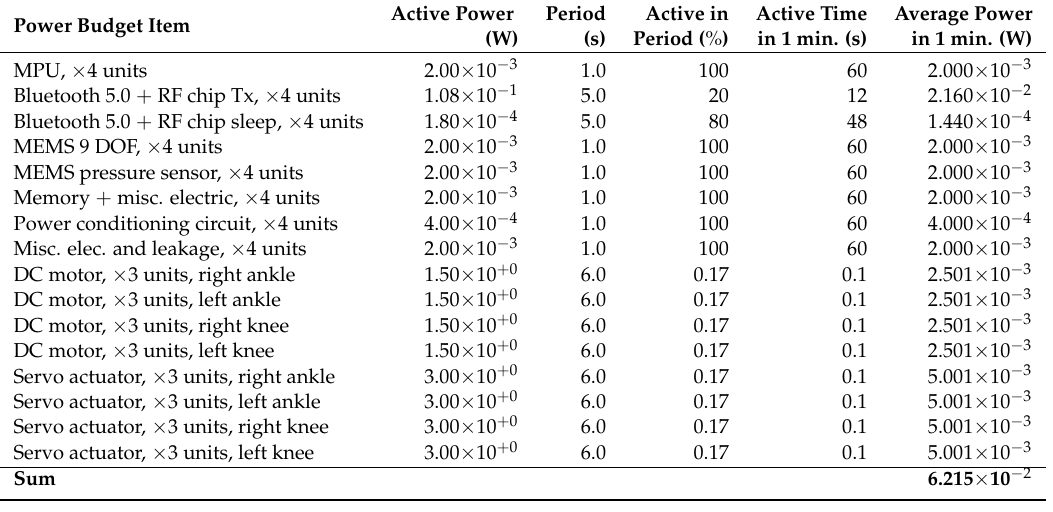
Table 3. Estimated power budget of a hypothetical smart prosthetic bionic leg with wireless sensing functionality and intermittent motor controlled ankle and knee adjustments for gait comfort optimisation.